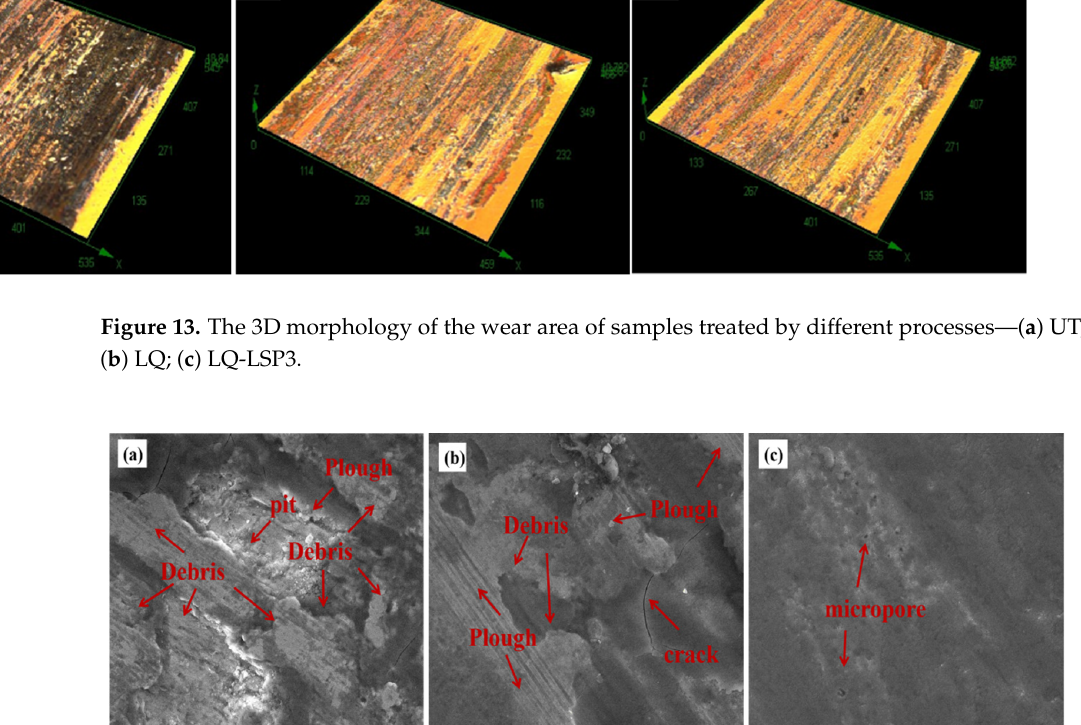
Figure 14. SEM morphologies of the wear marks of samples treated by different processes—( a ) UT; ( b ) LQ; ( c ) LQ-LSP3 . As shown in Figure 15, the oxygen content of the four samples is 24.6%, 8.9%, and 7.1%, respectively, indicating that the oxidation wear of Cr12MoV steel is reduced after LQ-LSP3. The base surface of UT specimens is spalling due to frictional wear, forming more pits and cracks. Oxide abrasives are more likely to adhere and accumulate on rough surfaces, and more oxidative wear will occur when the severely damaged surface is ex- posed to more oxygen in the air, resulting in more oxygen in the specimen [36]. LQ and LQ-LSP3 specimens have less exfoliation and oxidation, and the surface morphology re- mains basically flat and less prone to the adhesion of oxidation and severe oxidative wear.